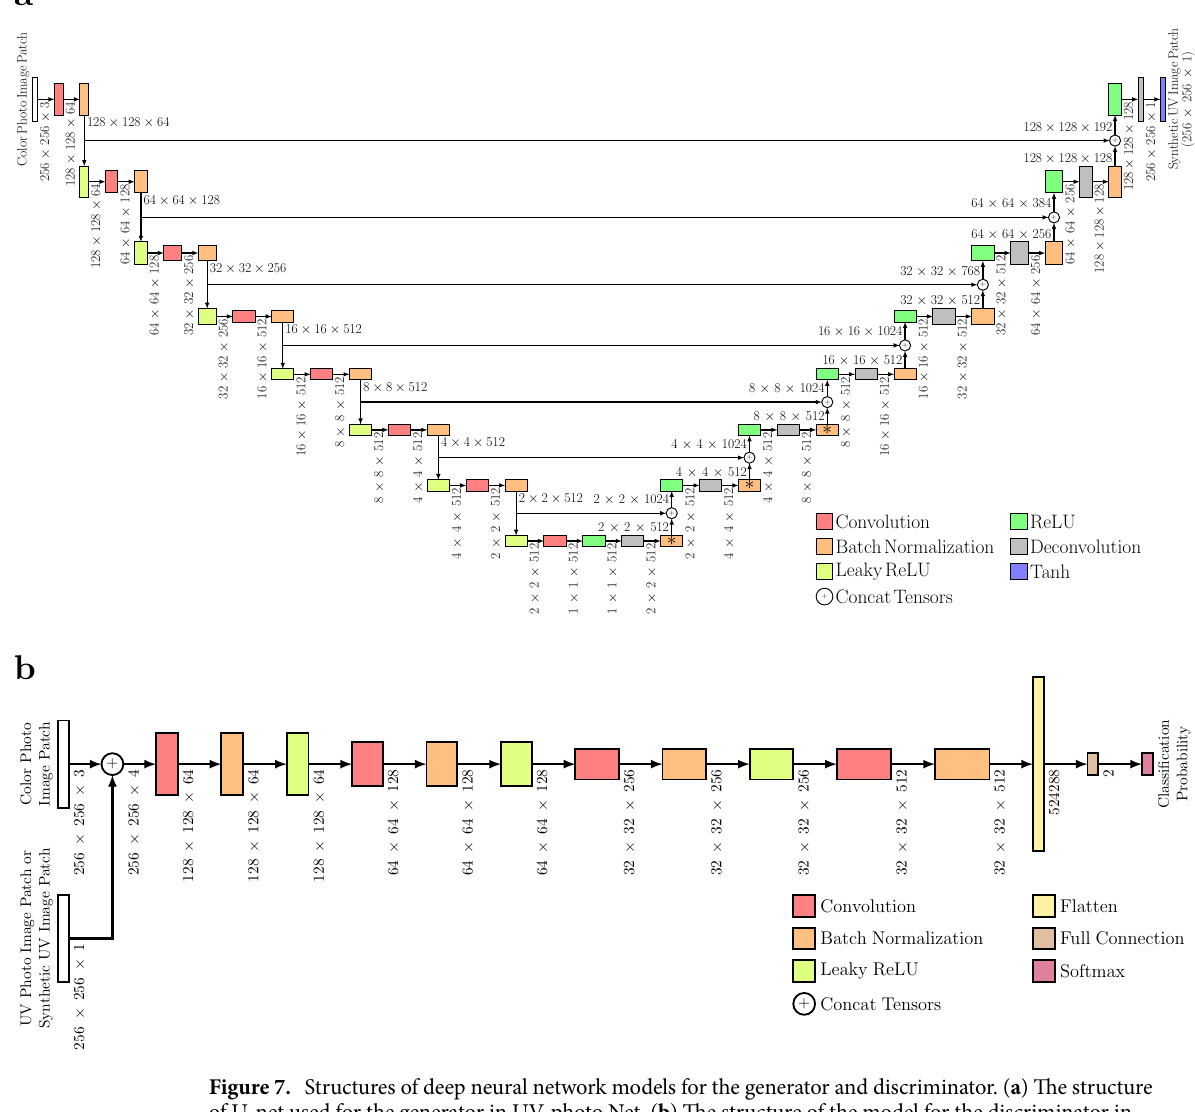
Figure 7. Structures of deep neural network models for the generator and discriminator. ( a ) The structure of U-net used for the generator in UV-photo Net. ( b ) The structure of the model for the discriminator in UV-photo Net. The value beside the outgoing arrow of each layer denotes the shape of the output tensor. The number of channels and image size of tree-dimensional output tensors are represented by the width and height of their rectangles, respectively. For vector-shaped output tensors, the height of their rectangles represents their respective vector length. The width of rectangles for the vector-shaped output tensors is equivalent to the size for one channel. Dropout was applied to the output tensors for the rectangles with